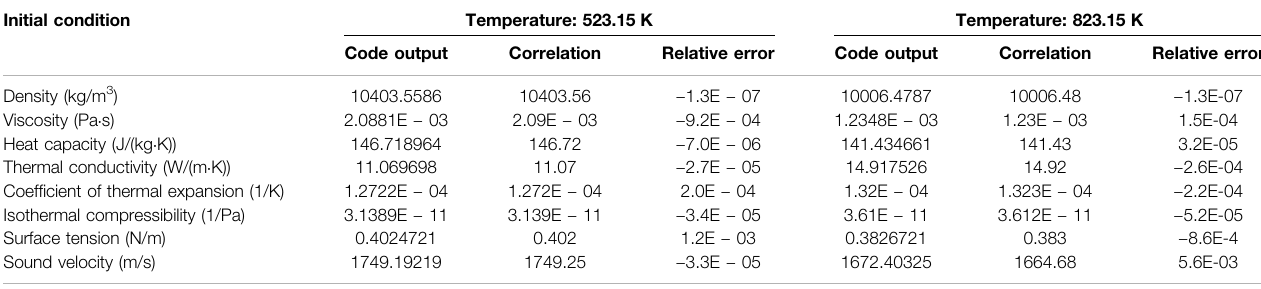
TABLE 1 | Accuracy test of LBE thermo-physical properties.